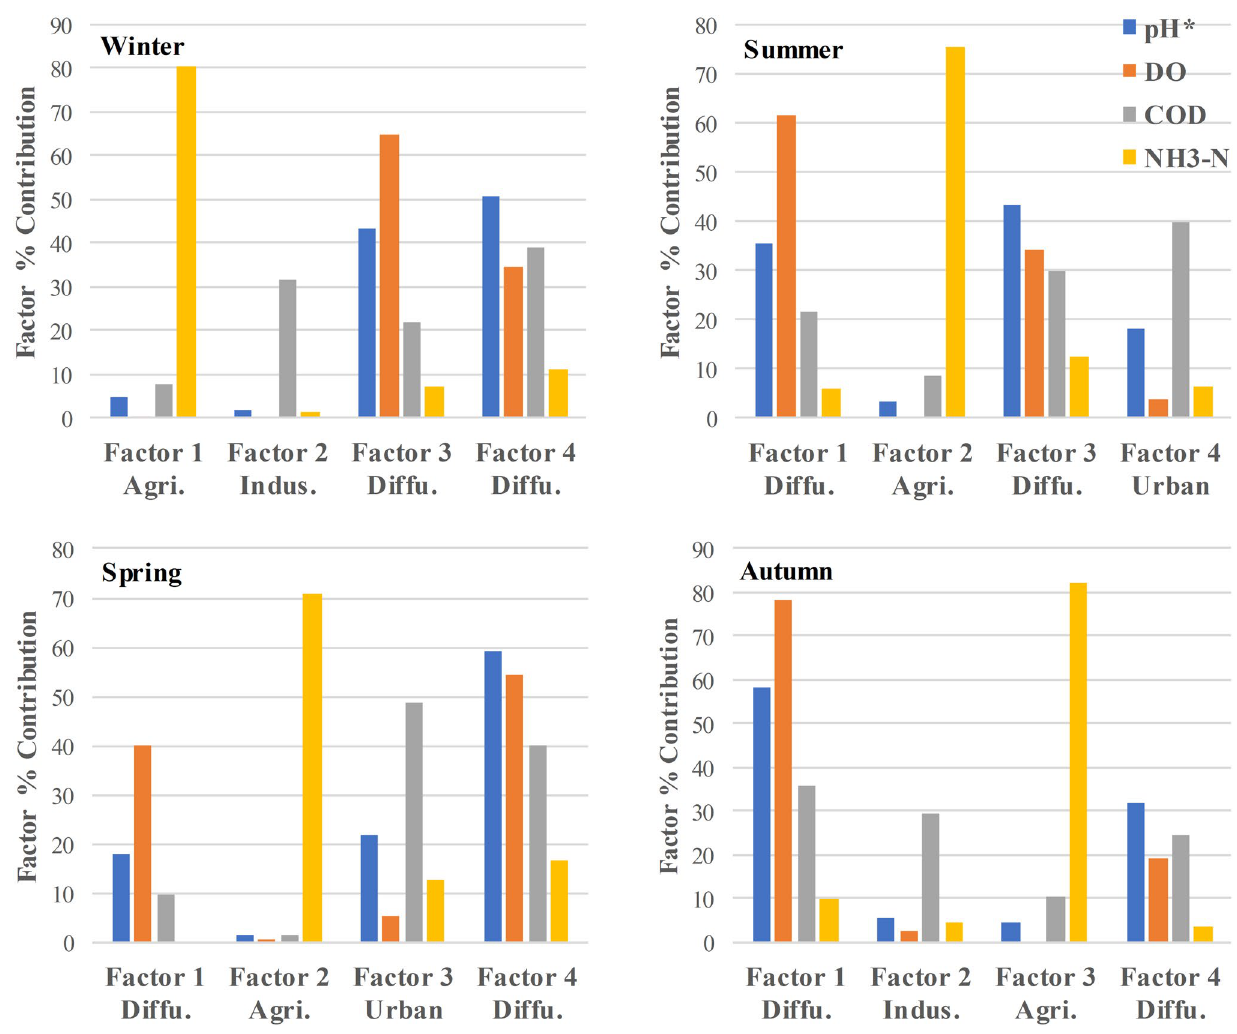
Fig. 4 Temporal factor loadings obtained from PMF analysis of water quality parameters of Huaihe River basin. Factors along with its cor- responding NPS are given. (For winter season: Factor 1 and Fac- tor 3 = diffused land use, Factor 2 = agricultural land use and Factor 4 = urban land use. For summer season: Factor 1 = agricultural land